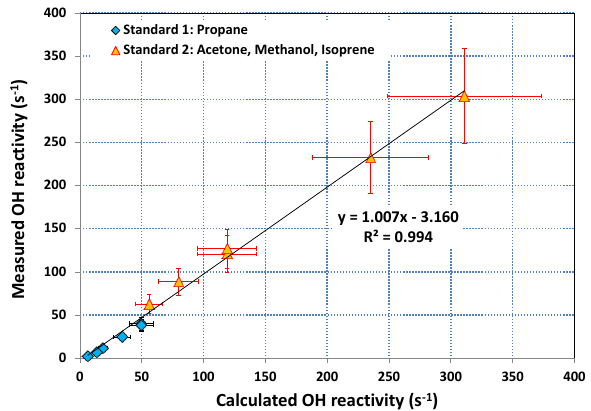
Figure 23. Calibration results using two standards bottles: propane and acetone, methanol and 3 Fig. 3. Calibration results using two standards bottles: propane and isoprene standard. Error bars stand for estimated uncertainty on the measured and calculated OH 4 acetone, methanol and isoprene standard. Error bars stand for es- reactivity (see text). 5 timated uncertainty on the measured and calculated OH reactivity (see text).